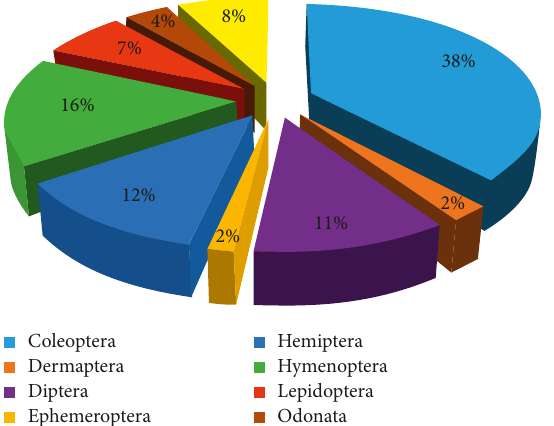
Figure 3: Percentage composition order of insects in all col- lected studied sites of three saline wetlands during study period (2016-2017). Figure